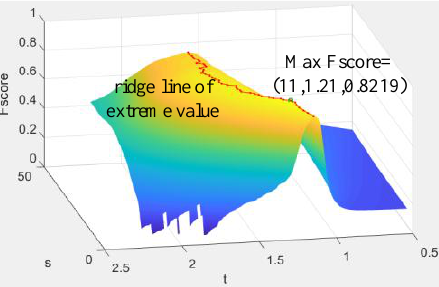
Figure 9. Curve surface of F_score changing with s and t of